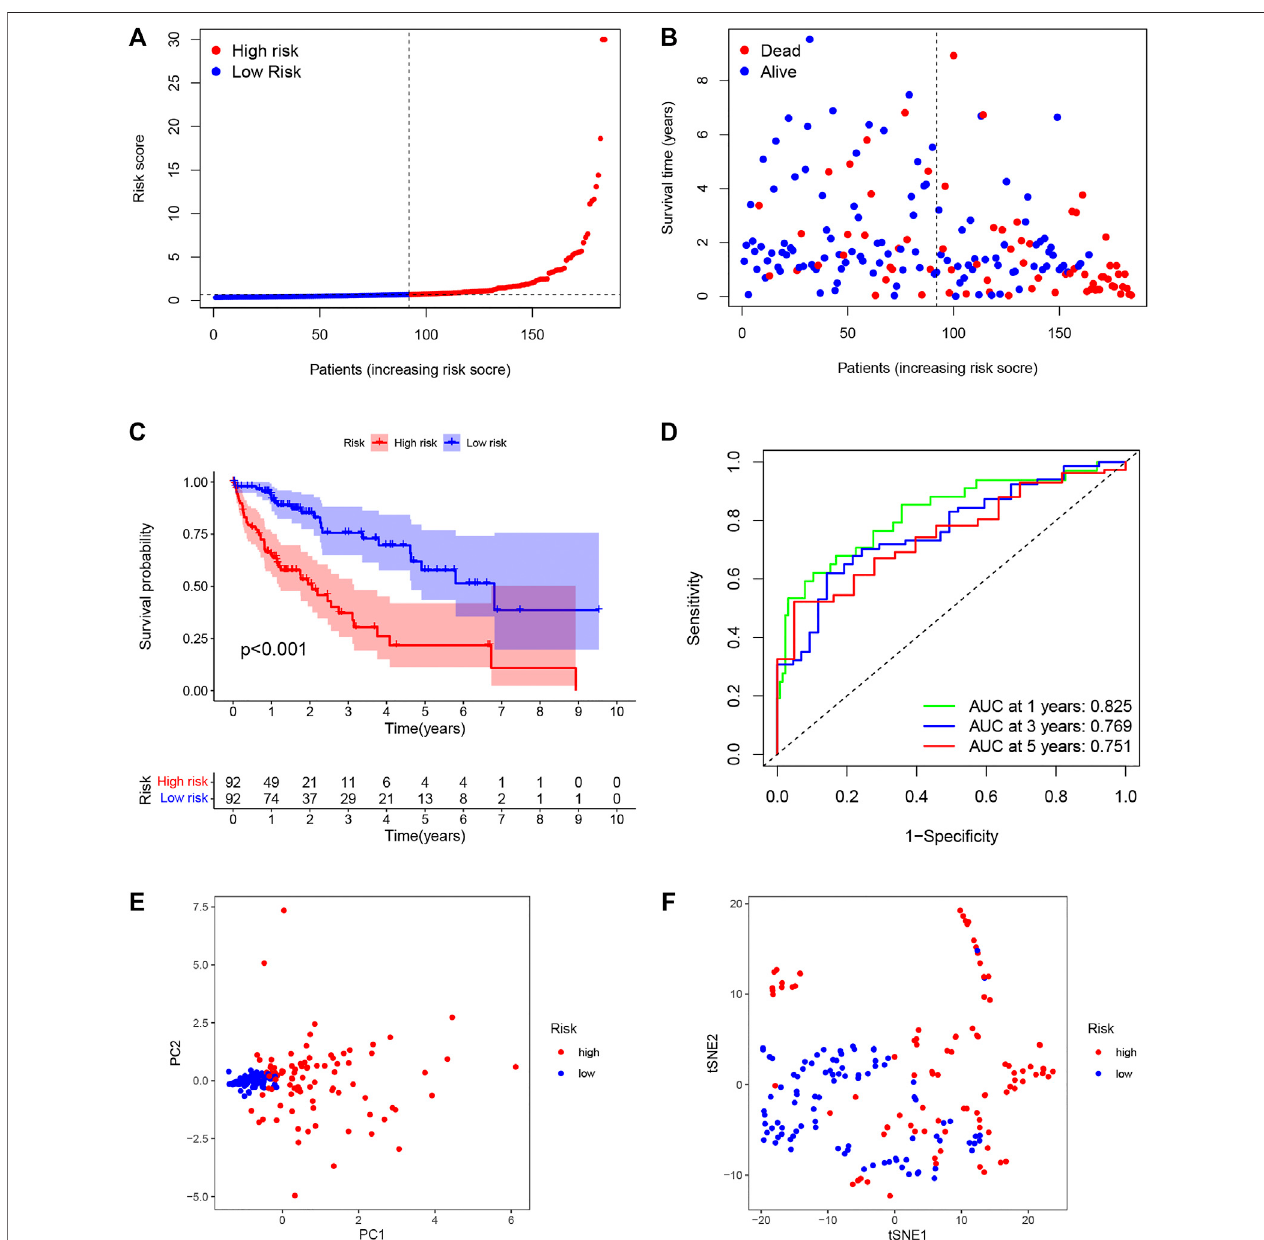
FIGURE4 | Establishmentof theDENRG-based OSsignature. (A) Distribution oftraining set risk scores. (B) OSstatusin theLIHC training set. (C) K-M analysisof OS in the two groups. (D) AUCs of ROC curves in training set. (E) PCA plot showing the signi fi cant difference between the two groups in the training set. (F) t-SNE uses dimensionality reduction to show the difference between the two groups in the training